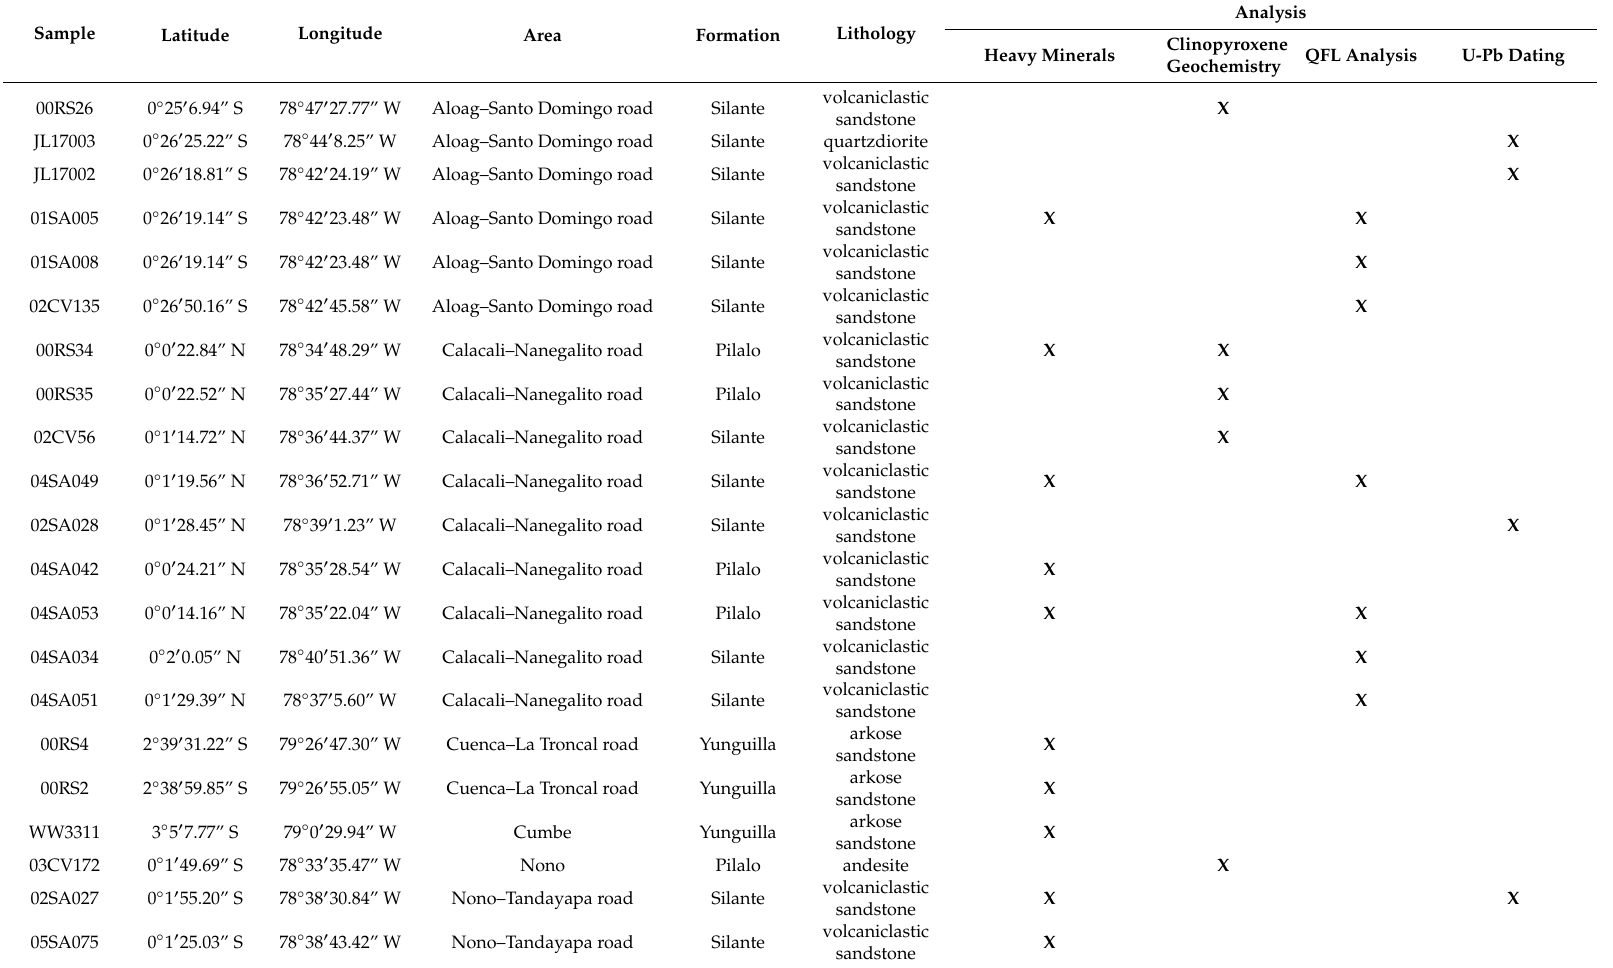
Table 1. Sample locations, and analysis performed in this